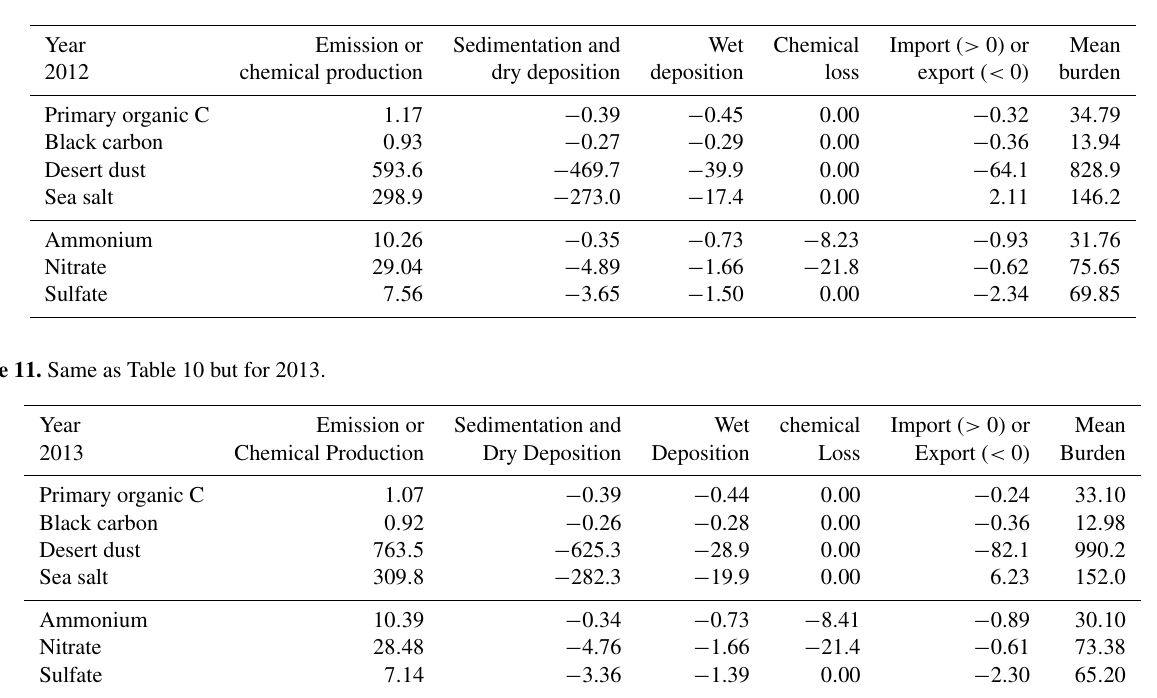
Table 10. Annual budget of the total mass of aerosols for the year 2012. The residual mass term corresponds to the values obtained when closing the budget. The different components are in teragrams (Tg) except the mean burden which is in gigagrams (Gg).